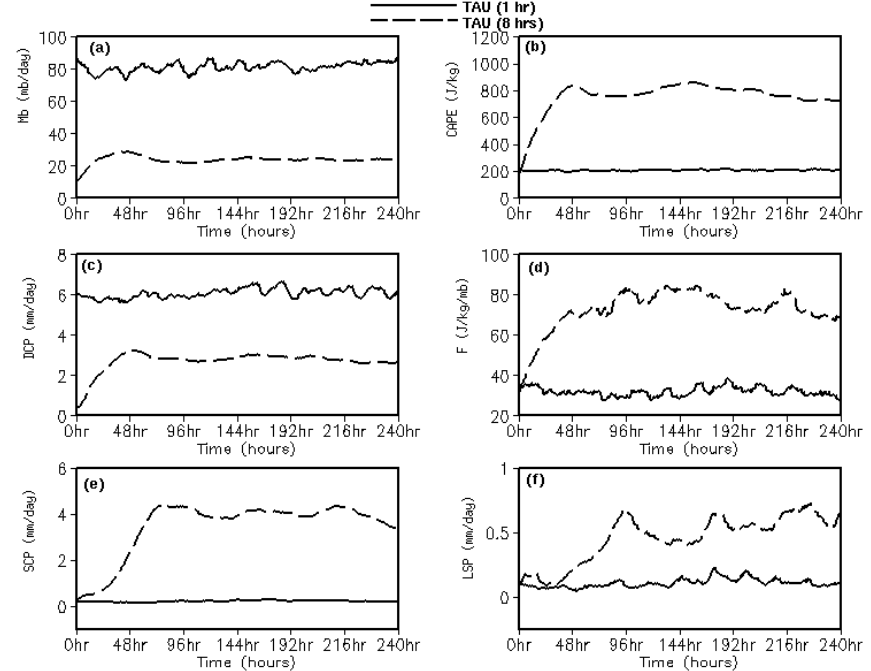
Fig. 15. Time evolution of area (12 ◦ S to 12 ◦ N and 0 ◦ E to 360 ◦ E) averaged quantities for integration with TAU (1h) and TAU (8h). (a) Cloud base mass flux (mb/day), (b) CAPE (J/Kg), (c) DCP. (d) F , which is CAPE consumption rate per unit cloud base mass flux (J/Kg/Mb), (e) SCP, and (f)